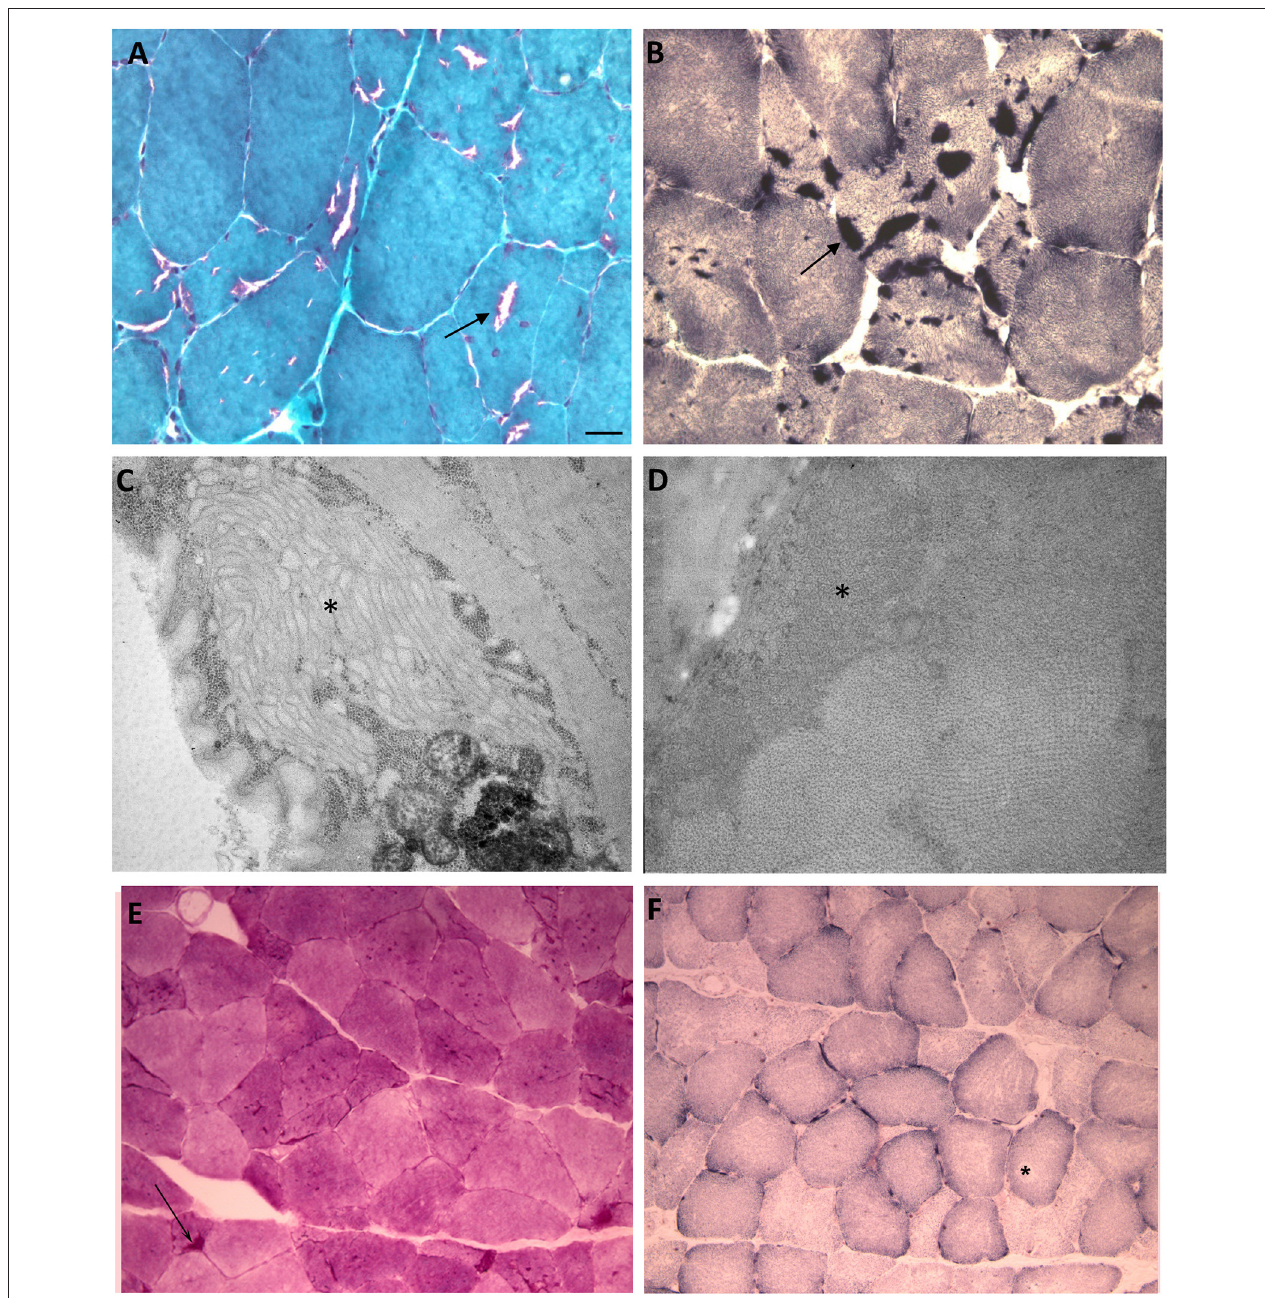
FIGURE 3 | Histological, histochemical and ultrastructural findings. (A) A Modified Gomori Trichrome stain (40X) showing tubular aggregates and a lack of tubular aggregates. (B) NADH (40X) reaction showing many cytoplasmic dark stained areas. (C,D) ( C : 12000X) ( D : 20000X) EM. Subsarcolemmal evidence of tubular aggregates (asterisks). (E) small accumulations of PAS positive material was detected in some fibers. (F) SDH staining showed no accumulations even in the described vacuolated areas. Scale bar: (A,B) 12.5 µ m (C) 0.42 µ m (D) 0.25 µ m (E, F) 25 µ